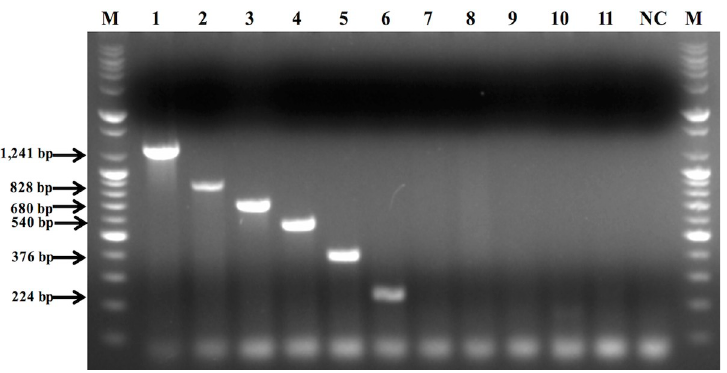
Fig 2. Comparison of six species-specific primer sets with other bacterial genus and species. All primer sets were pooled for the multiplex PCR reaction. M, size marker(bp); 1, Lactobacillus gasseri ; 2, Lactobacillus acidophilus ; 3, Lactobacillus helveticus ; 4, Lactobacillus jensenii ; 5, Lactobacillus crispatus ; 6, Lactobacillus gallinarum ; 7, Lactobacillus plantarum ; 8, Lactobacillus salivarius ; 9, Lactobacillus reuteri ; 10, Enterococcus faecalis ; 11, Enterococcus faecium ; NC, negative